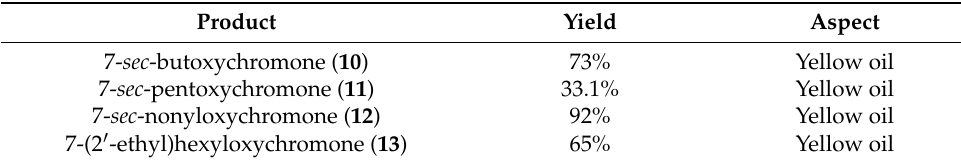
Table 14. Yields and aspects of synthesized products. Product Yield Aspect 7- sec -butoxychromone ( 10 ) 73% Yellow oil 33.1% Yellow oil